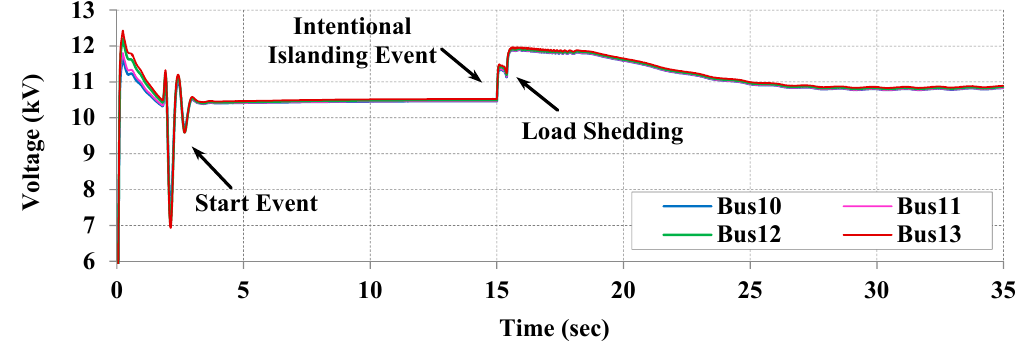
Figure 14. Voltage profile in island-2 recovers after load shedding.